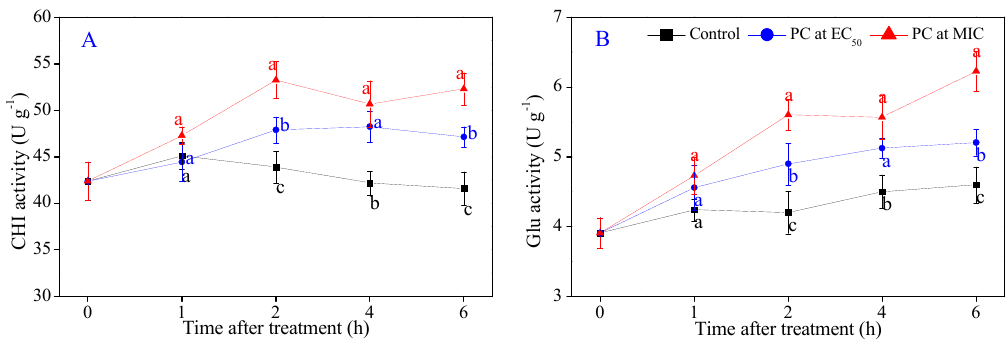
Figure 7. Effects of P7G on chitinase (CHI) activity ( A ) and β -1,3-glucanase ( β -Glu) activity ( B ) of P. italicum in PDB. Each value is the mean of three replicates ( n = 3), and the vertical bar indicates the standard error (S.E.). The values with different lowercase letters within the same time point indicate a significant difference between the control and the P7G-treated mycelia, according to Duncan’s test at p < 0.05.